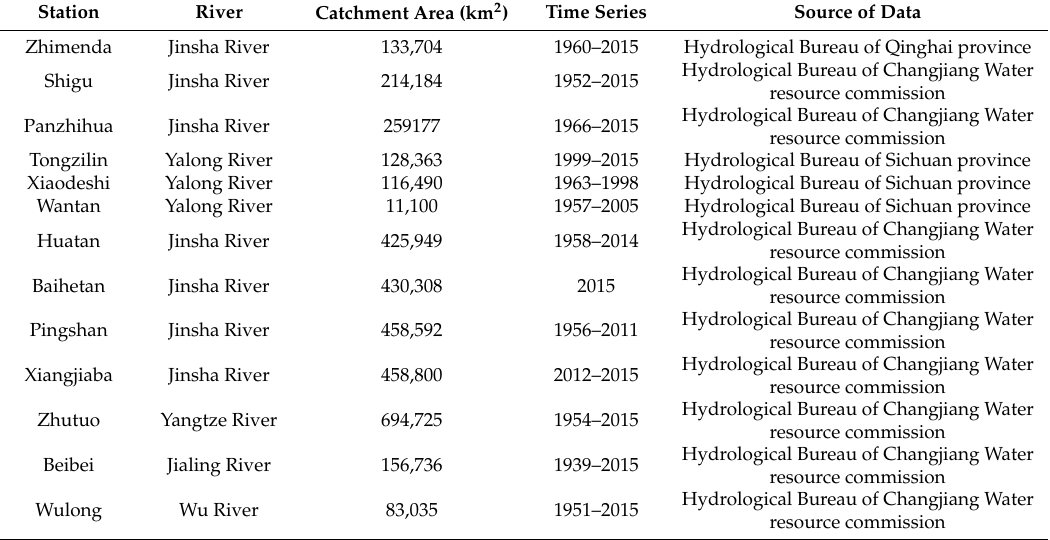
Table 1. Basic information of relevant hydrological stations in the study